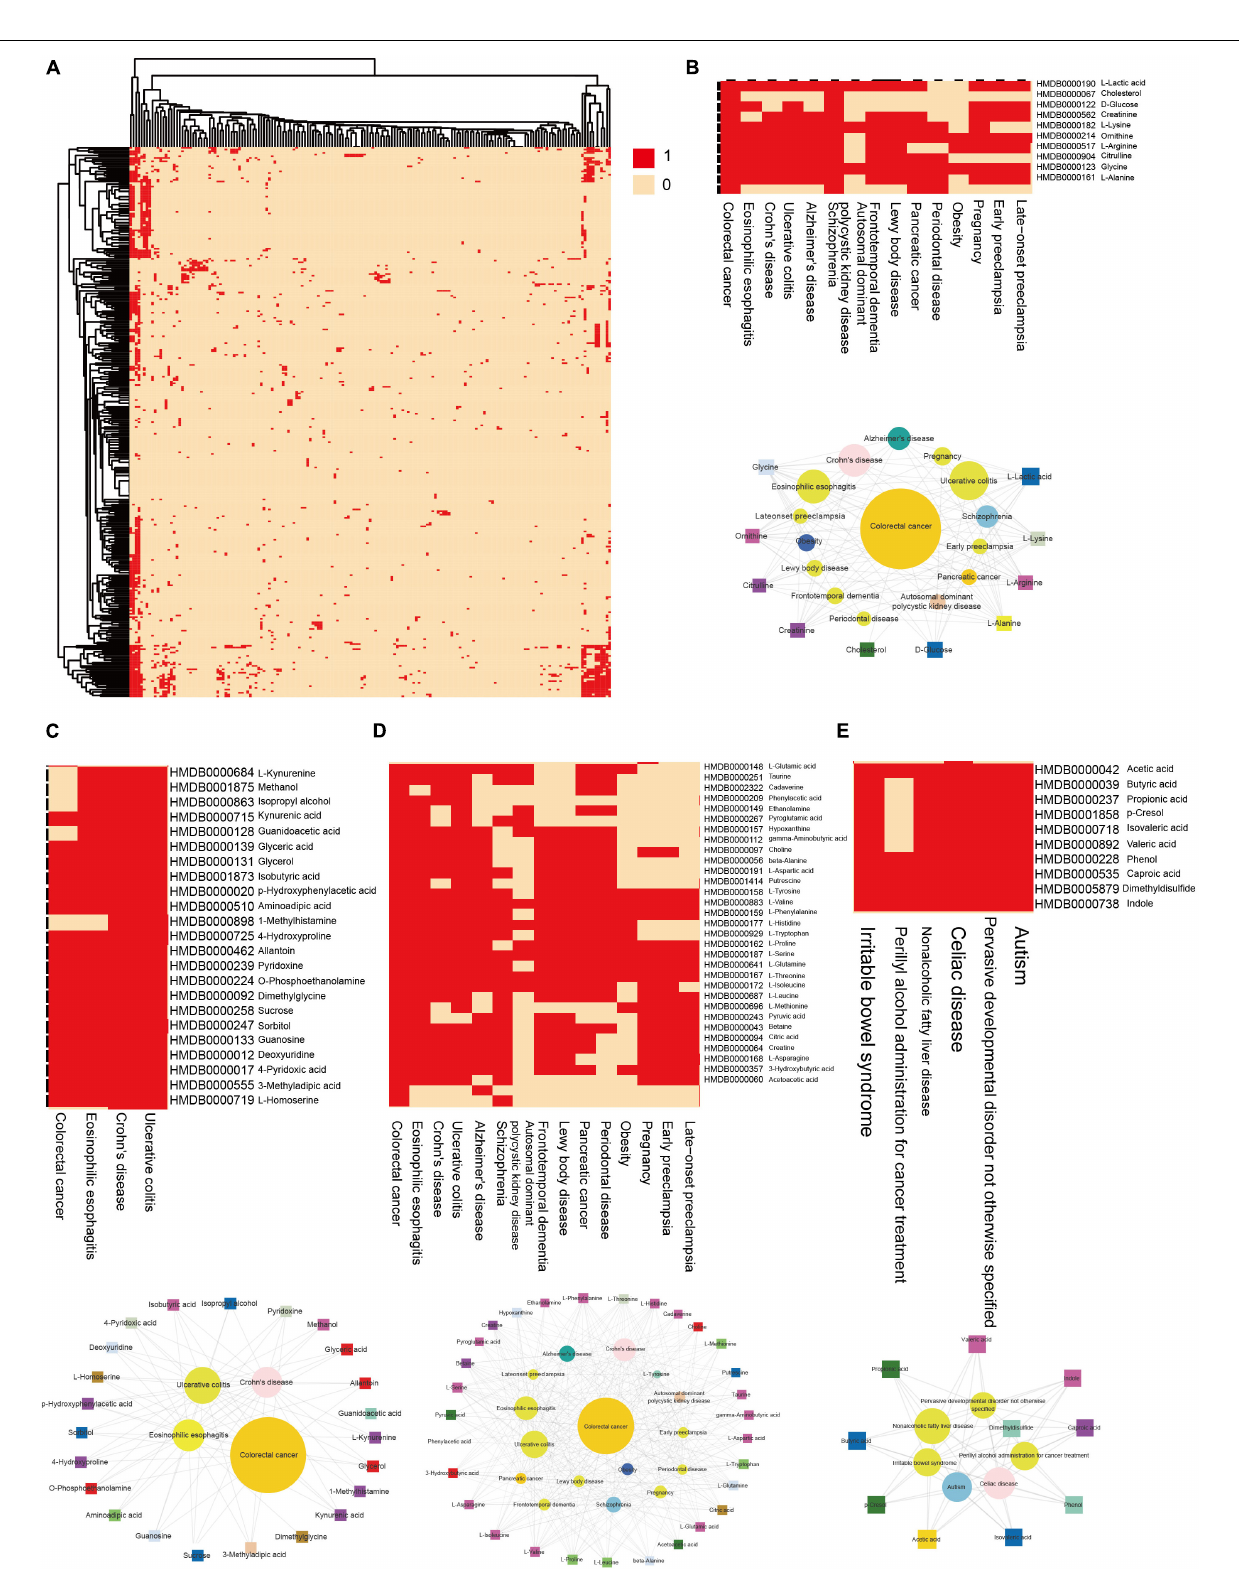
Frontiers in Bioengineering and Biotechnology | www.frontiersin.org